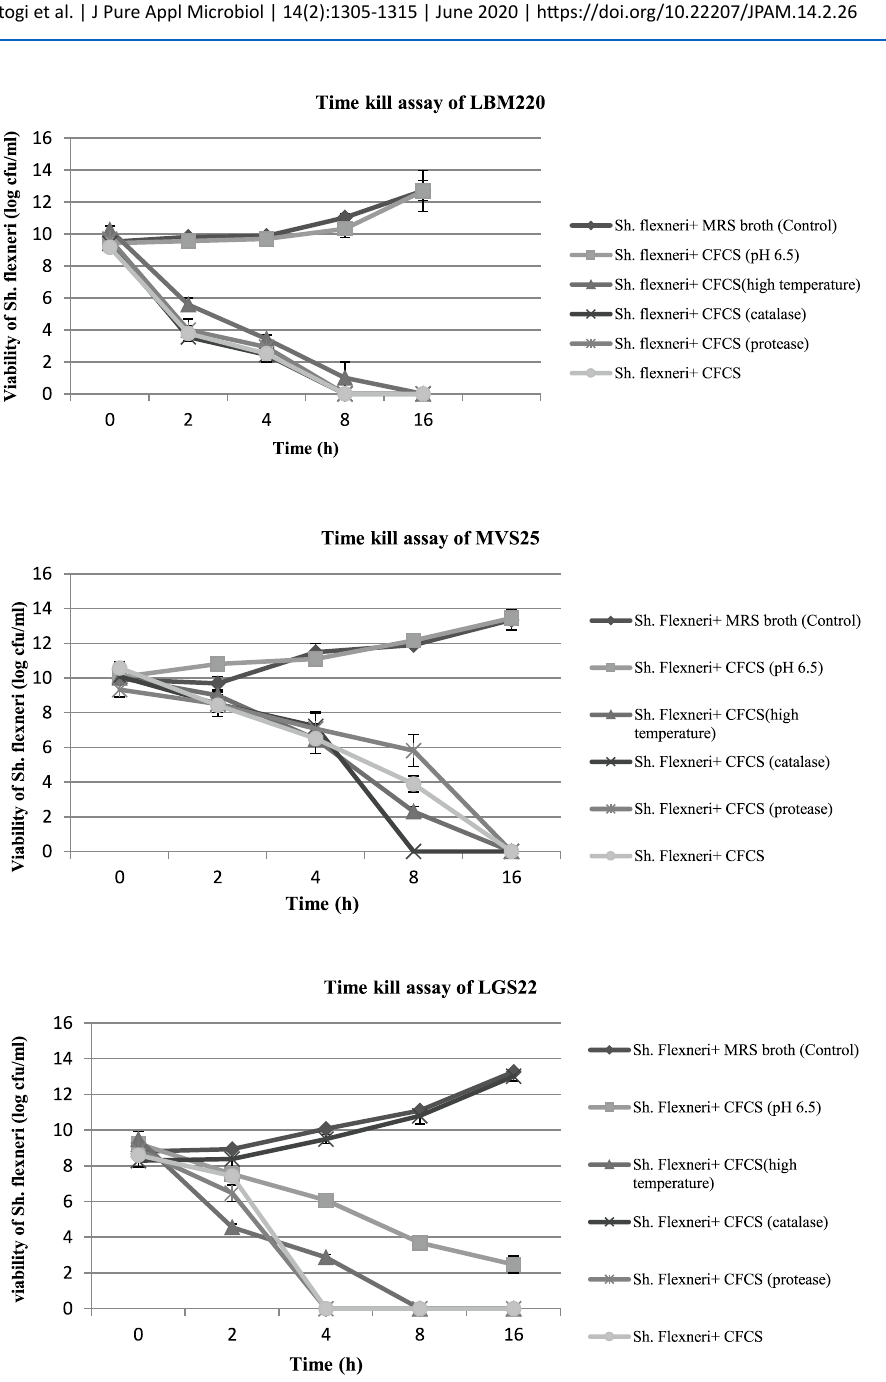
Fig. 2(A-C). Evaluation of all three Lact. gasseri strains (LBM220, MVS25 and LGS22) cell-free culture supernatant (CFCS) kill assay on pathogen Sh. flexneri by the contact time. Sh. flexneri was incubated in untreated CFCS, CFCS neutralized to pH 6.5, CFCS protease treated, CFCS catalase treated, CFCS heat treated and sterile MRS broth (pH 6.5) as control. Aliquots were removed at 0h, 2h, 4h, 8h and 16h. Serially diluted and plated on BHI to determine colony counts in log cfu ml -1 . Each value is expressed as mean ± SD